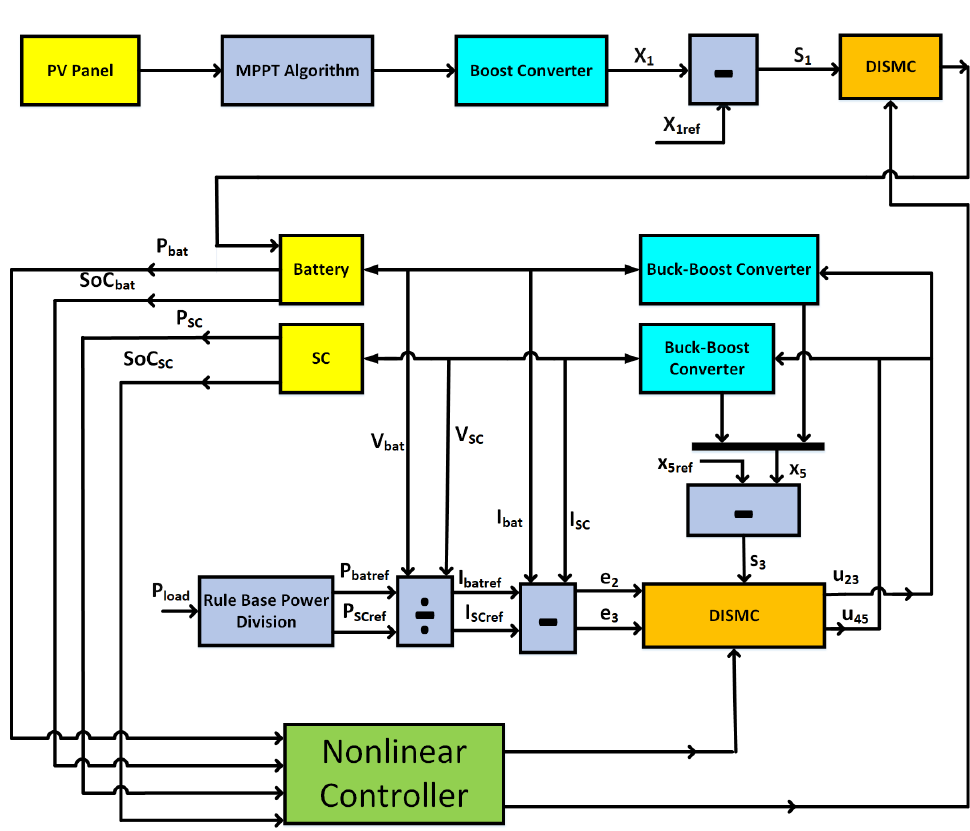
Figure 1. General Architecture of a DC